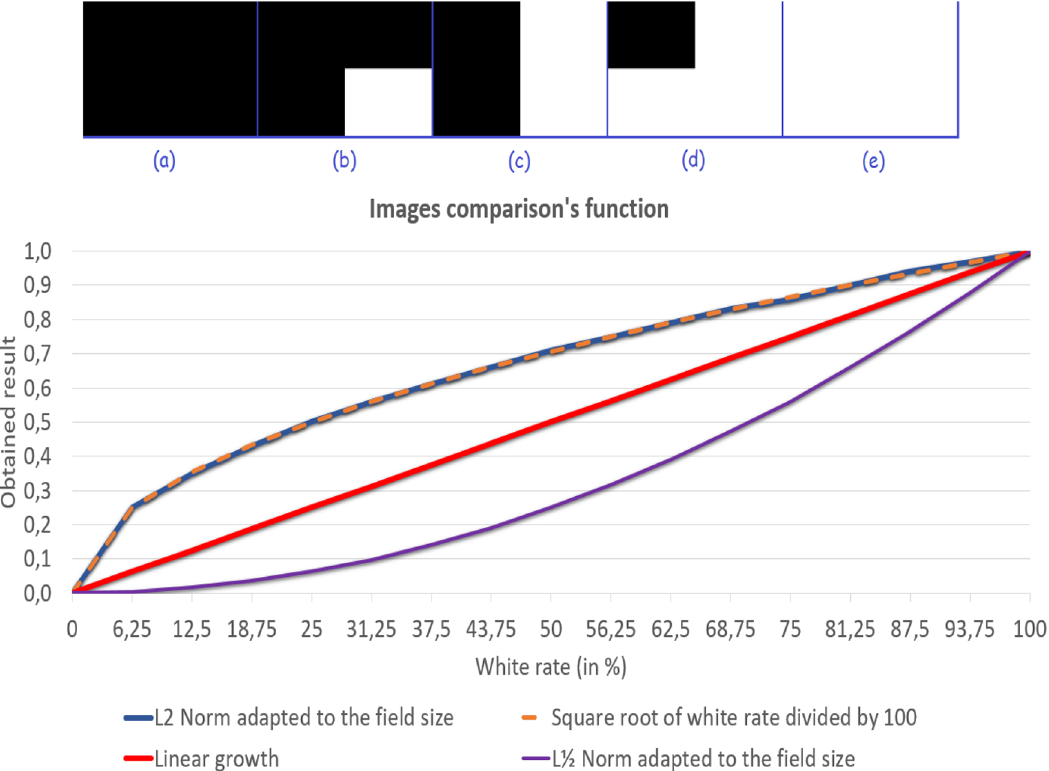
Fig. A1. Test of L 2 norm for image comparison ’ s function (f) with black and white images with respectively 0% (a), 25% (b), 50% (c), 75% (d), and 100% (e) of white. [Reprinted/Adapted] with permission from [22] © The Optical